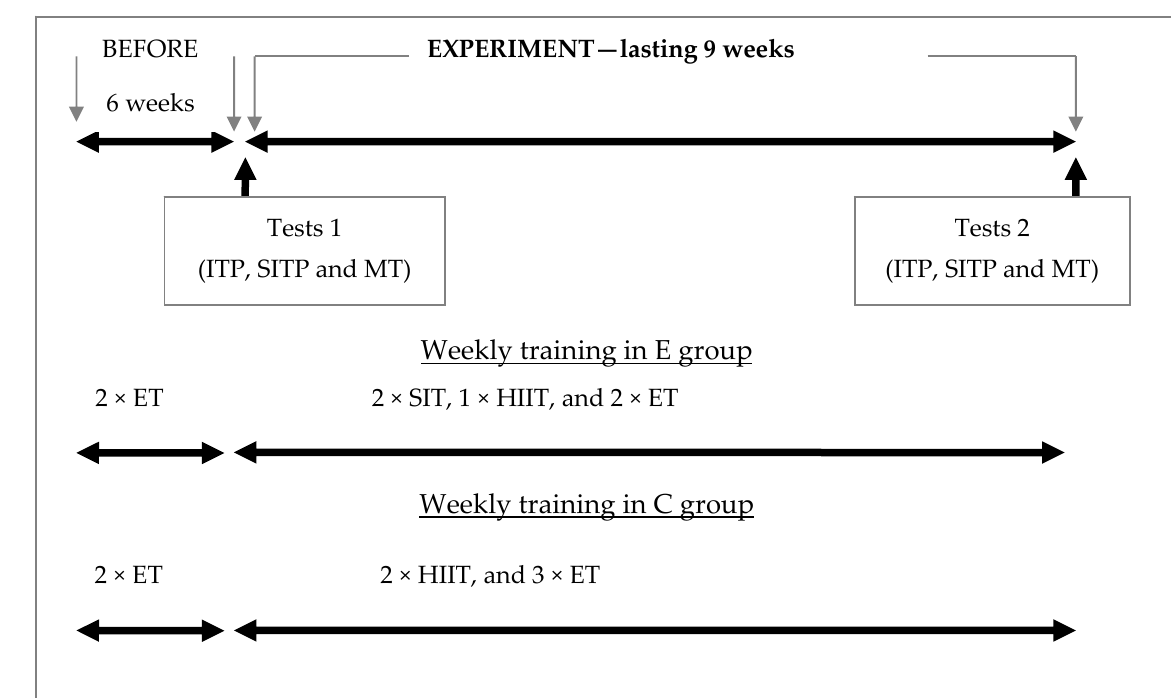
Figure 1. Scheme of the experiment (ITP—incremental testing protocol; SITP—sprint interval testing protocol; MT—muscle thickness measurements; E—experimental group; C—control group; ET—endurance training; SIT—sprint interval training; HIIT—high intensity interval training).